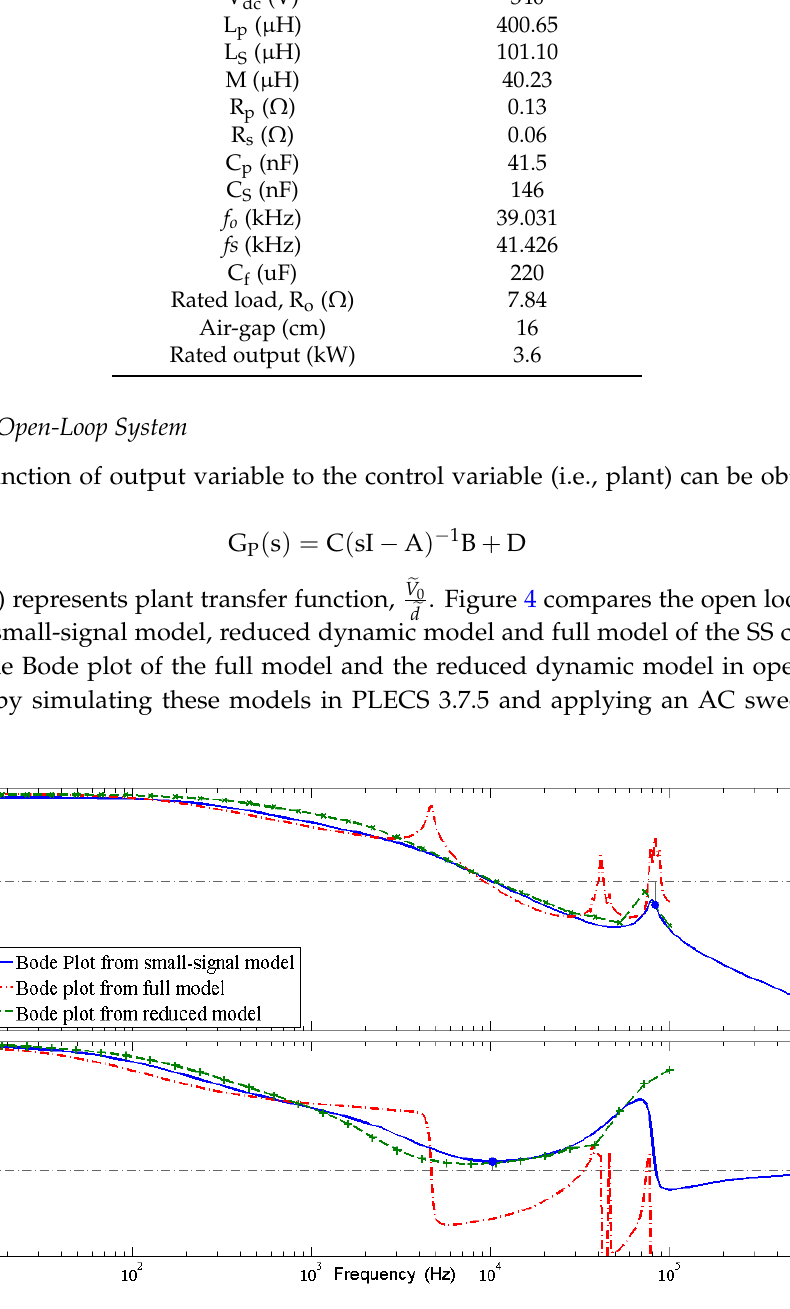
Figure 4. Open loop Bode plot of